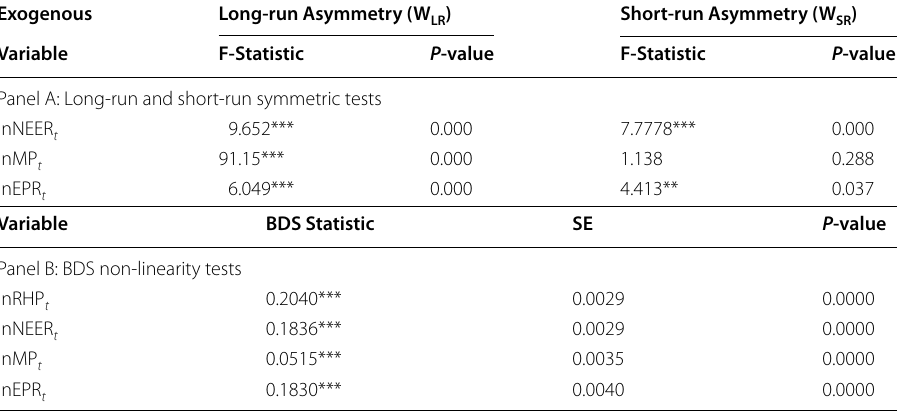
** and *** denote 1% and 5% significance levels. W LR and W SR indicate the Wald test for the long‑ and short‑run with their respective P ‑values Superscript ***shows a significance level at 0.01 with a maximum cor. dimension of